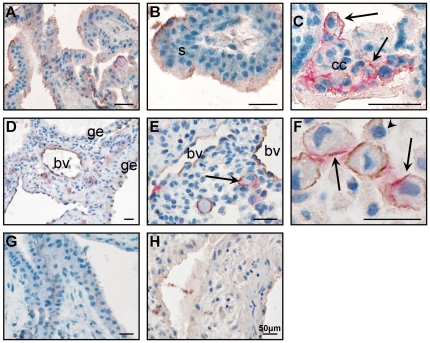
Annexin A2 (brown) and HLAG (pink) co-localization in placental villous (A–C) and decidua basalis (D–F).A. Annexin A2 localization in the placental villous. B. Annexin A2 localized to the syncytiotrophoblast (s). C. Annexin A2 and HLAG co-localilzed to extravillous trophoblast (EVT, arrows) in the cell column (cc). D. Annexin A2 localization in the decidua basalis. E. Annexin A2 localized to endothelial cells of blood vessels (bv) and to iEVT (arrow) in the decidua basalis. F. Annexin A2 and HLAG co-localizaation to EVT (arrows) in the decidua basalis. G. Negative (IgG) control for placental villous. H. Negative (IgG) for decidua. Scale bar: 50 µm.